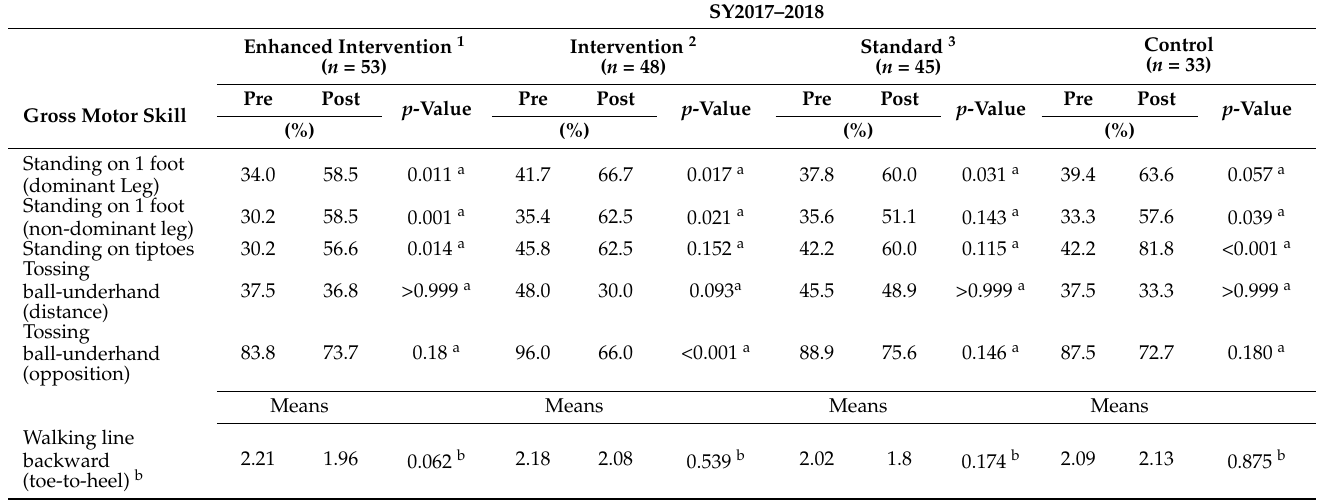
Table 3. Percent of preschool child participants that met gross motor (GM) skill proficiency and mean scale score for walking line backgrounds at pre- and post-study period during school year (SY)